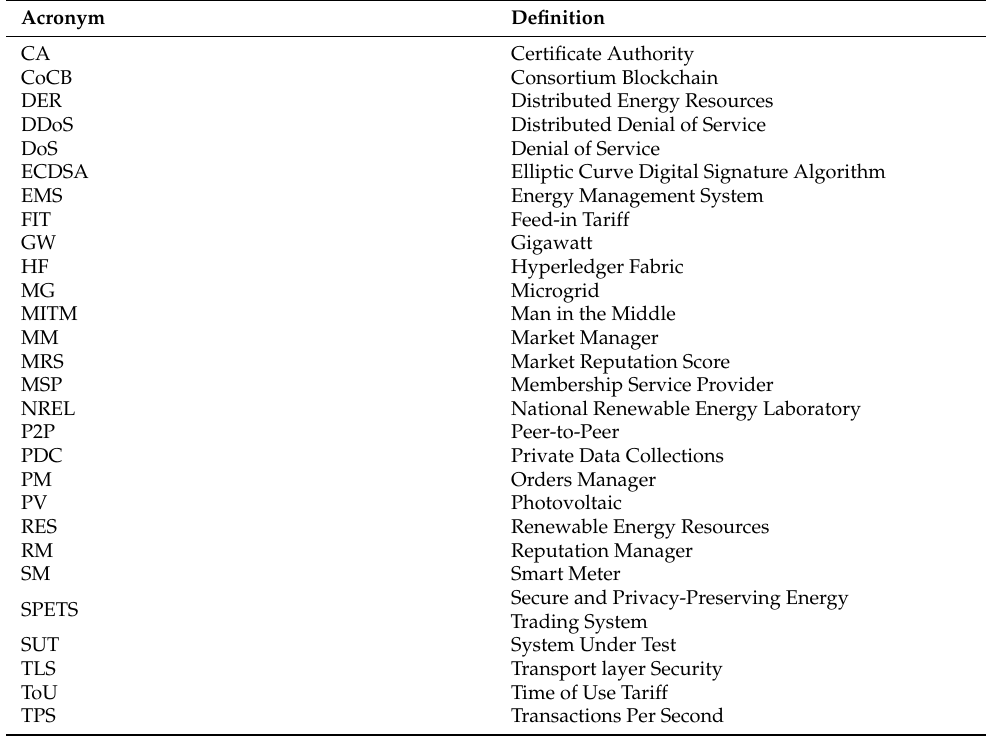
Table A2. Acronyms used in this